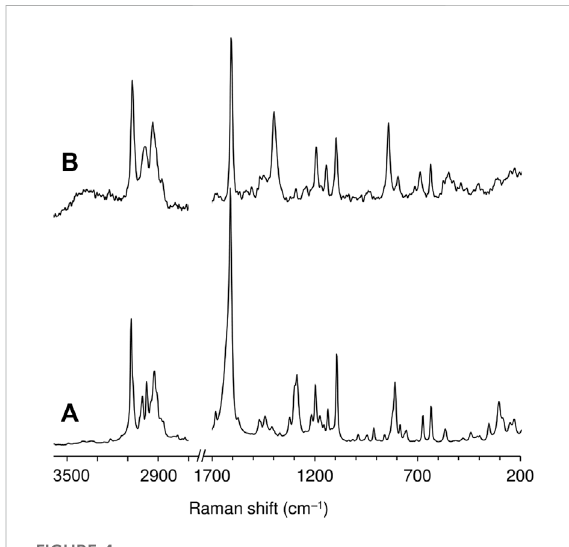
FIGURE 4 FT-Raman spectra in the ranges 200 – 1,700 and 2,700 – 3,600 cm − 1 of (A) ketodiacid 3 and (B) LDH-KDA3. FIGURE 5